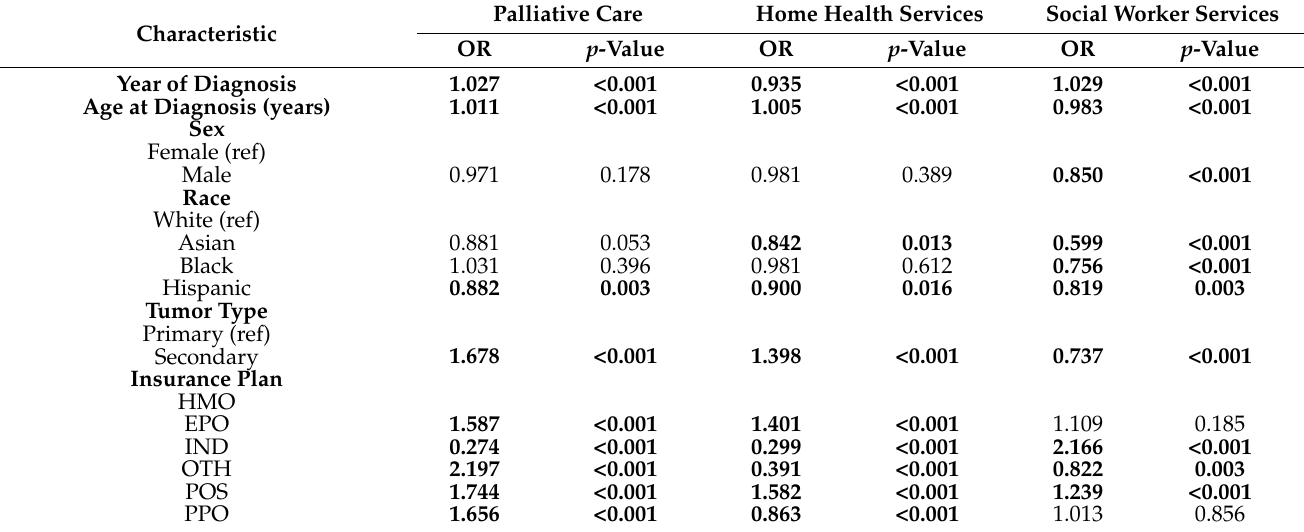
Table 2. Mixed effects model evaluating incidence of supportive care service